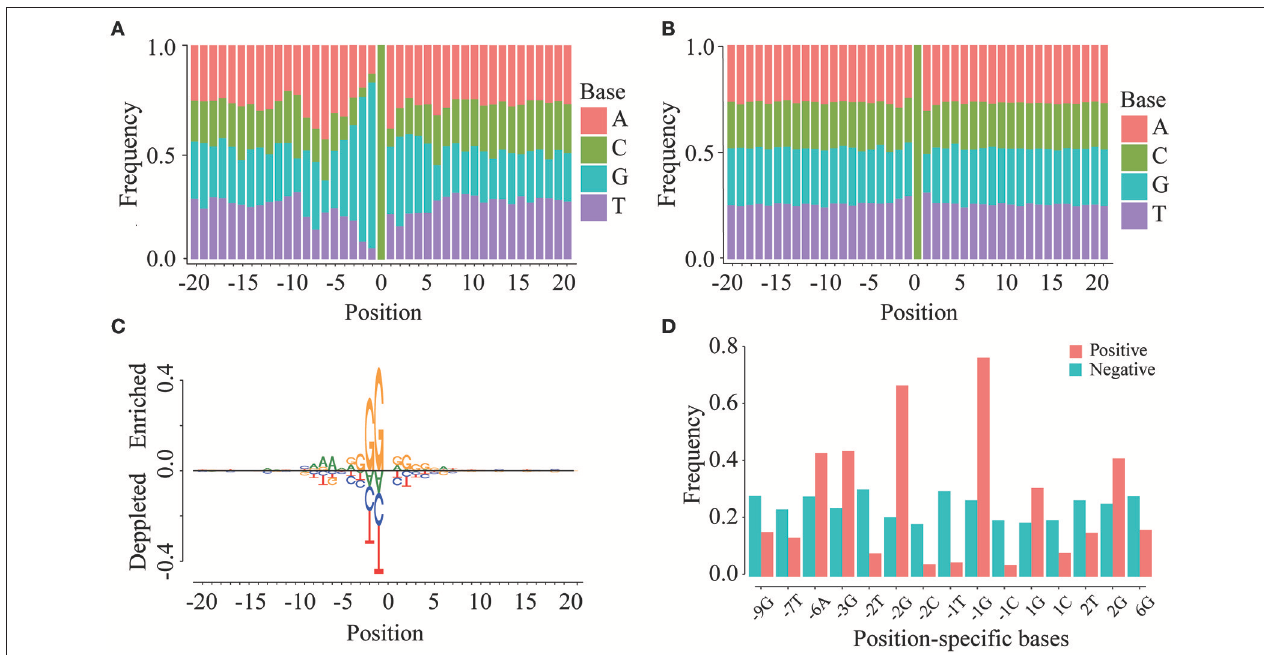
FIGURE 3 | Position-specific base usage in positive and negative samples. The region around ( − 20, 20) around the cytosine sites is used to perform position-specific base usage analysis, where the cytosines are defined as 0. (A) Frequencies of 41 × 4 position-specific bases in positive samples. (B) Frequencies of 41 × 4 position-specific bases in negative samples. (C) Two sample logo of the differences between m 5 C and non-m 5 C modifications. It shows nucleotides which are enriched or depleted in the surrounding regions of m 5 C modifications. (D) With a significance level of 1.0E-10, the usage of 15 position-specific bases is significantly different between m 5 C and non-m 5 C